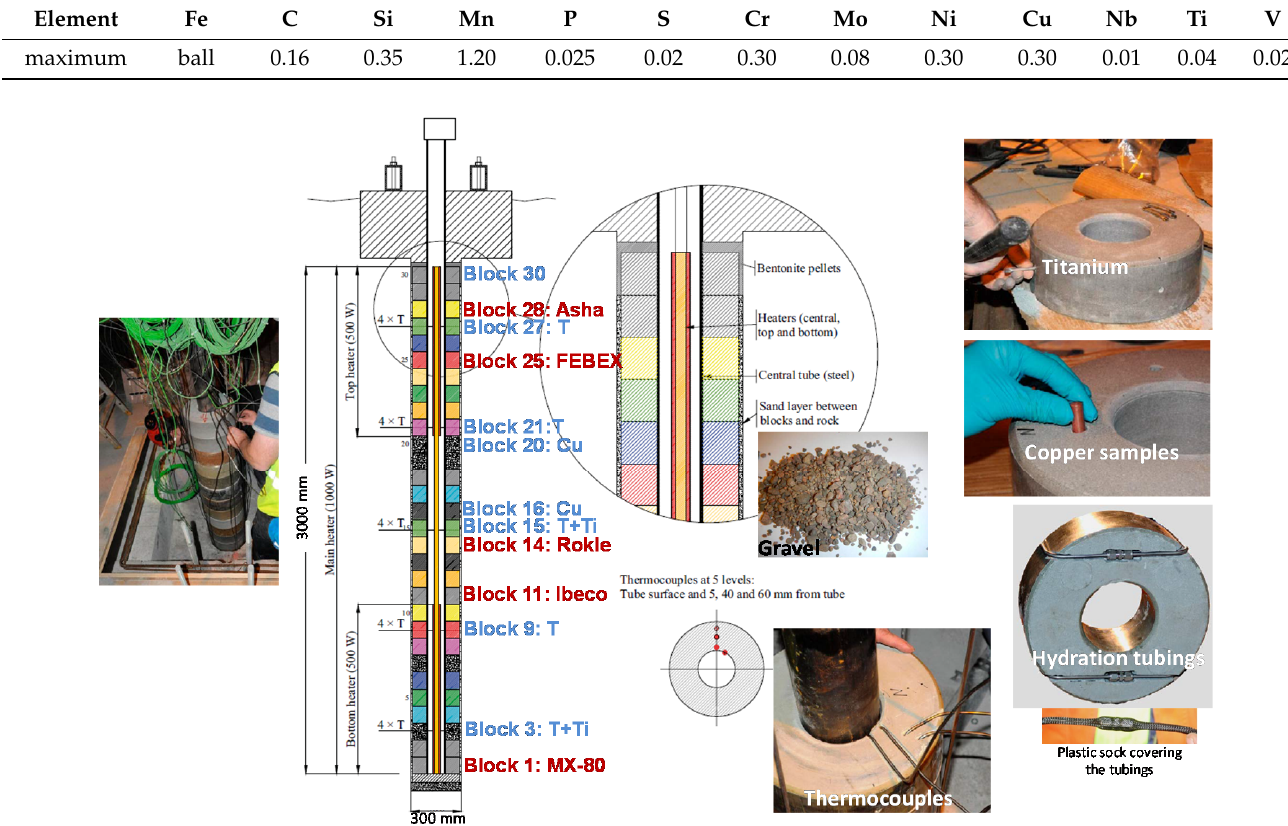
Table 1. Chemical composition in wt.% of carbon steel (steel grade P235TR1): EN 10216-1-2014.